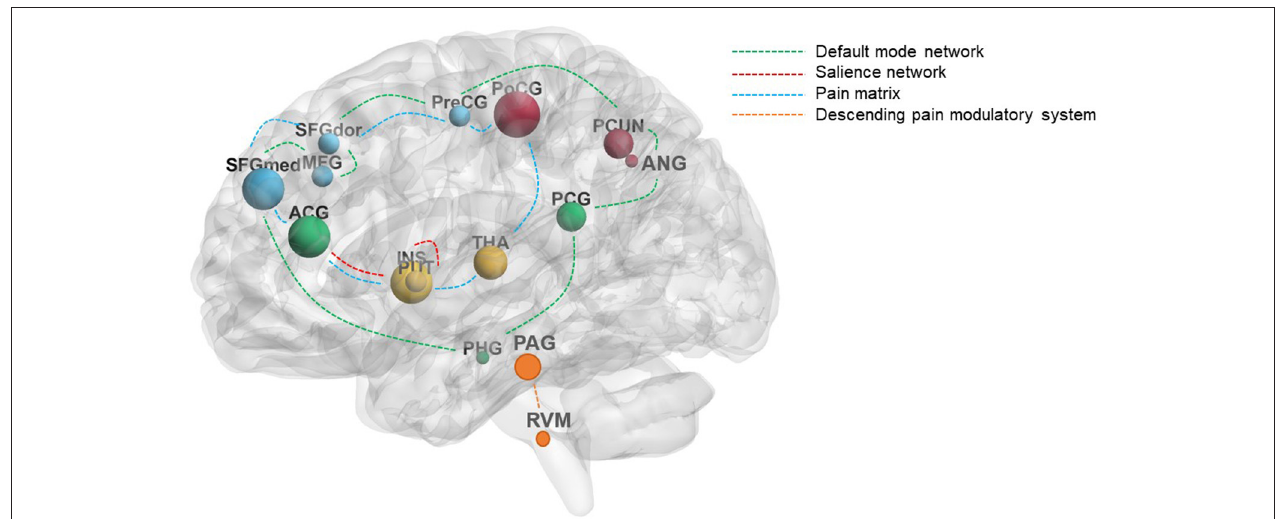
FIGURE 3 | The main reported brain regions induced by acupuncture in LBP patients. The size of the nodes represents the frequency of the brain regions; the different colors of the dashed lines represent the different modulation pathways of acupuncture. The green dashed lines mainly represent the default mode network, the red dashed lines mainly represent the salience network, the blue dashed lines mainly represent the pain matrix, and the yellow dashed lines mainly represent the descending pain modulatory system. ACG, cingulate gyrus, anterior part; ANG, angular gyrus; INS, insula; LBP, low back pain; MFG, middle frontal gyrus; PAG, periaqueductal gray; PCG, cingulate gyrus, posterior part; PCUN, precuneus; PHG, parahippocampus; PoCG, postcentral gyrus; PreCG, precentral gyrus; PUT, putamen; RVM, rostral ventral medulla; SFGdor, superior frontal gyrus, dorsolateral; SFGmed, superior frontal gyrus, medial; THA,